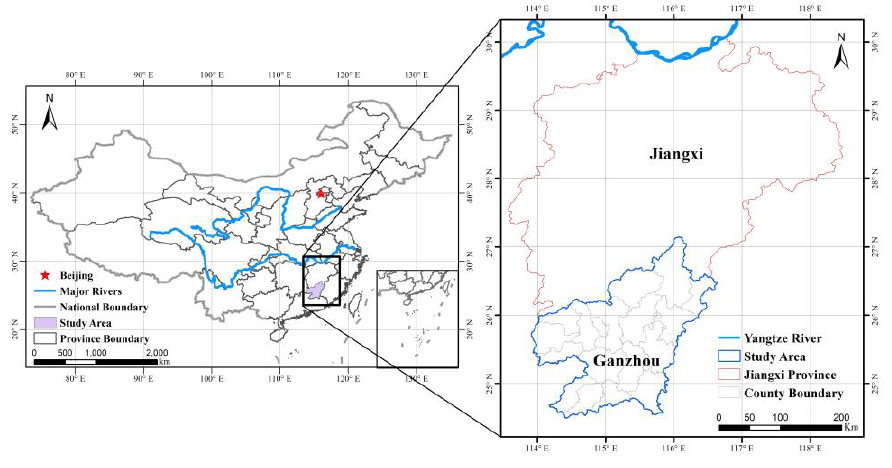
Figure 2. Geographical map of the study area.